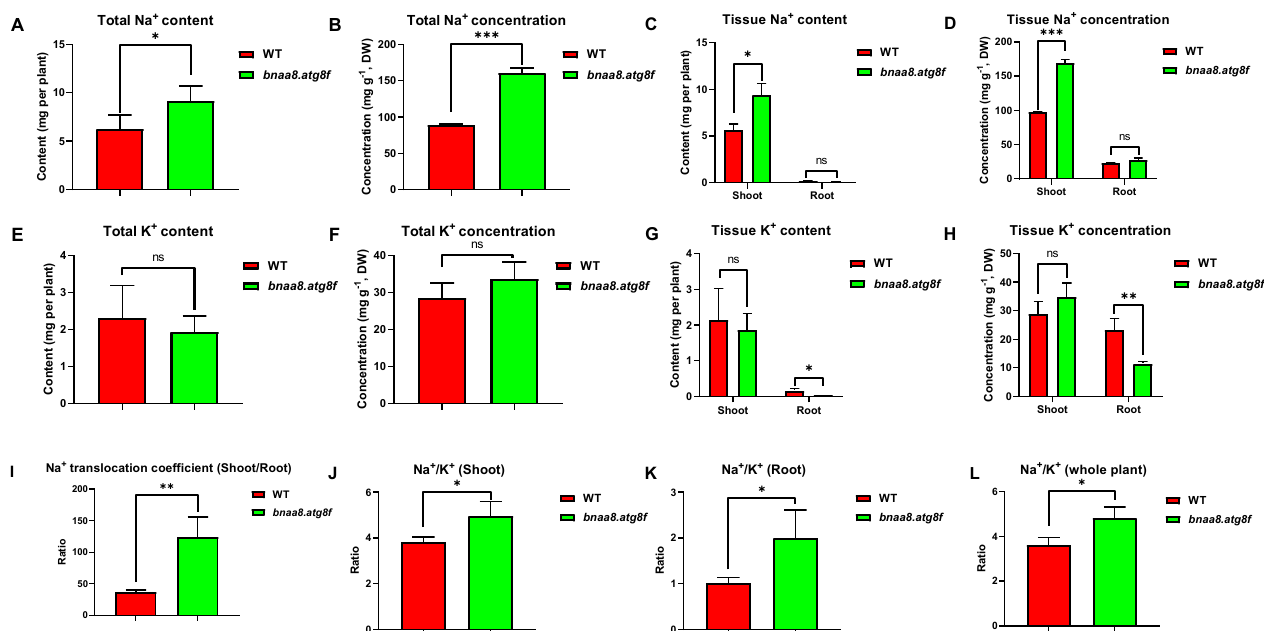
Figure 5. Sodium (Na) and potassium (K) ion profiling of the wild type and bnaa8.atg8f trangenic plants grown under salinity conditions. Following germination, uniform seedlings were selected and grown hydroponically under NaCl-free conditions for 10 d and then transferred to 200 mM NaCl for 5 d. ( A ) Total plant Na + contents, ( B ) total plant Na + concentrations, ( C ) shoot and root Na + contents, ( D ) shoot and root Na + concentrations. ( E ) total plant K + contents, ( F ) total plant K + concentrations, ( G ) shoot and root K + contents, ( H ) shoot and root K + concentrations, ( I ) Na + translocation coefficient (root content/shoot content), ( J – L ) Na + /K + ratios of ( J ) the shoots, ( K ) roots, and ( L ) the whole plant. Data are means ( ± SD), n = 3. Significant differences were determined using Student’ s t -test: *, p < 0.05; **, p < 0.01; ***, p < 0.001; ns, not significant.